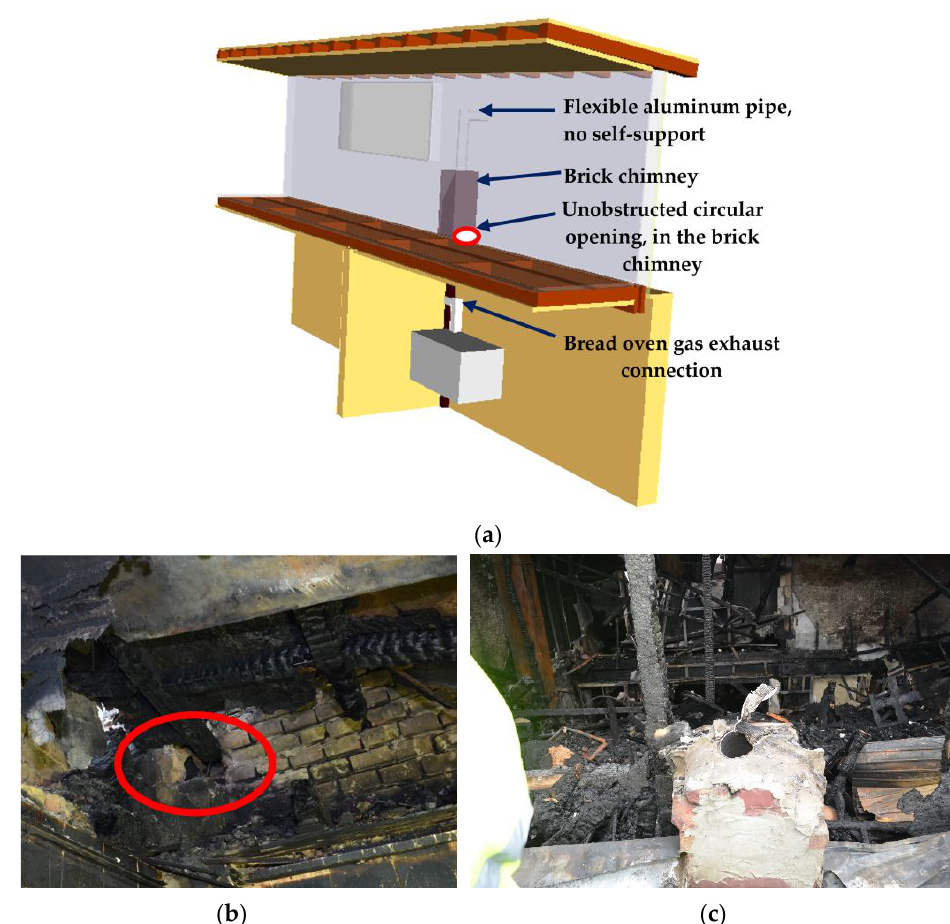
Figure 3. Hypothesis (1). Building section (ground and first floor), eastern wall ( a ); details of the unobstructed hole in the brick chimney ( b ); upper limit of the chimney with flexible aluminum tube extension ( c ).